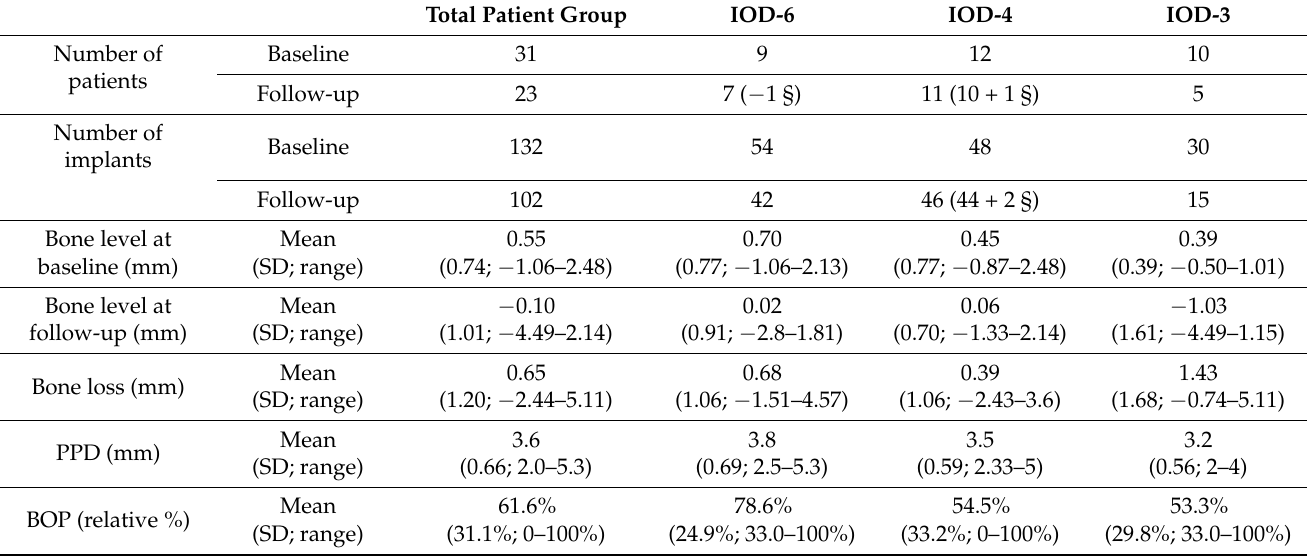
Table 1. Table showing descriptive results of the population and clinical outcomes at baseline and at time of follow-up.